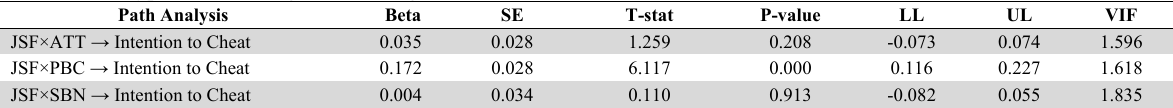
The result of hypotheses testing (moderating effect) Path Analysis